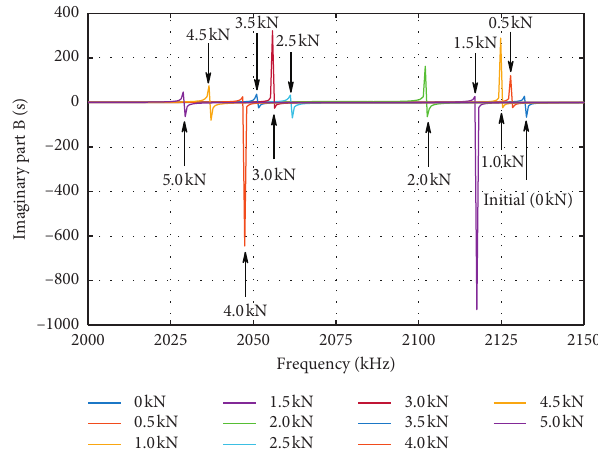
Figure 6: Admittance (imaginary part) signatures at different load conditions between 2000kHz and 2150kHz excitation.